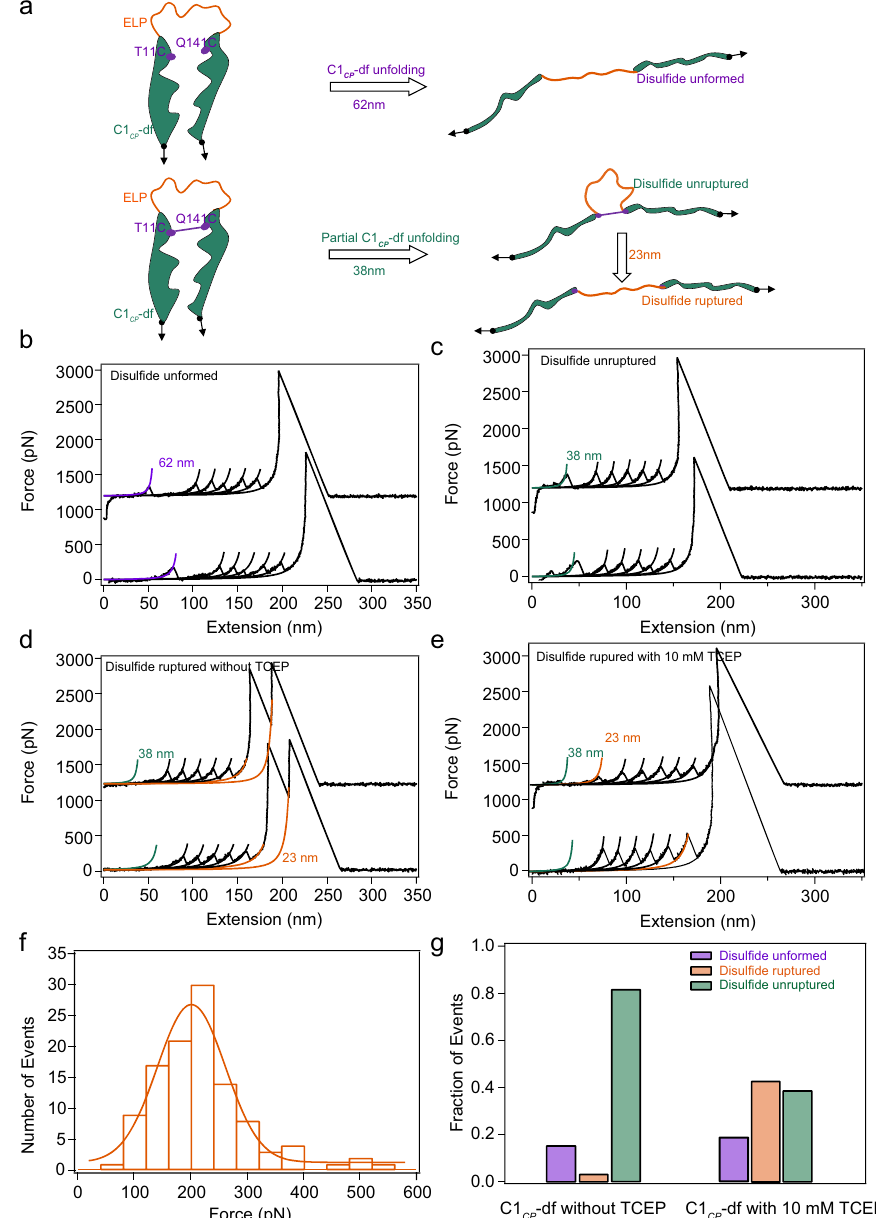
Fig. 6 Mechanical unfolding of C1 CP -df. C1 CP -df was constructed in the same way as C1 CP except that the ester bond was replaced by a disul fi de bond. a Three possible unfolding/hydrolysis pathways of C1 CP -df under load and the corresponding contour length change. b Representative force – extension curves of the “ Disul fi de unformed ” group. c Representative force – extension curves of the “ Disul fi de unruptured ” group. Representative force – extension curves of the “ Disul fi de ruptured ” group in PBS with ( d ) and without ( e ) 10 mM TCEP. f Histogram of the mechanical rupture force of disul fi de bond in PBS with 10 mM TCEP. Fitting the force distribution with Monte Carlo simulation results in a Δ x u of 0.13 nm and 0 of 0.39 s − 1 (Supplementary Fig. 18). g 2D bars show the relative populations of the three kinds of events without (left, n = 844) or with 10 mM TCEP (right, n = 754). This experiment was repeated more than fi ve times independently with similar results. Source data are provided as a Source Data fi